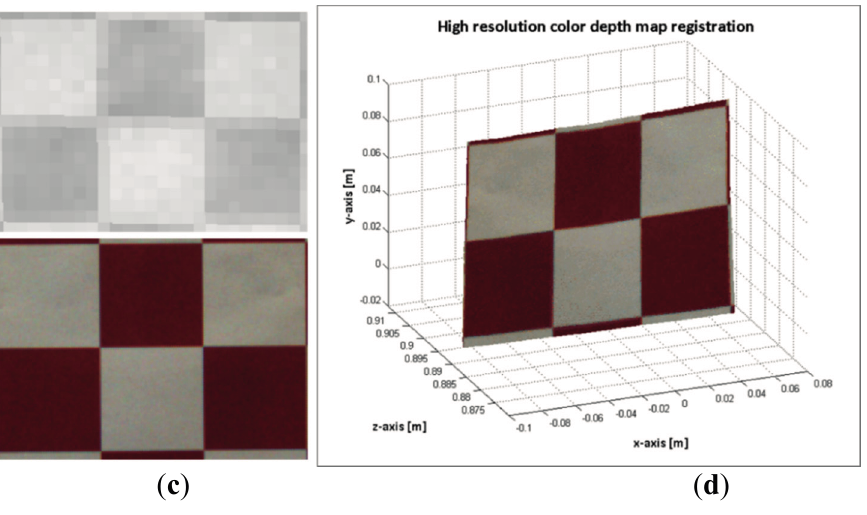
Figure 10. Image sample 49. ( a ) Top: mapped points on the ToF image. Bottom: points of the ROI on the RGB image; ( b ) high resolution colour depth map; Image sample 25; ( c ) Top: mapped points on the ToF image. Bottom: points of the ROI on the RGB image; ( d ) high resolution colour depth